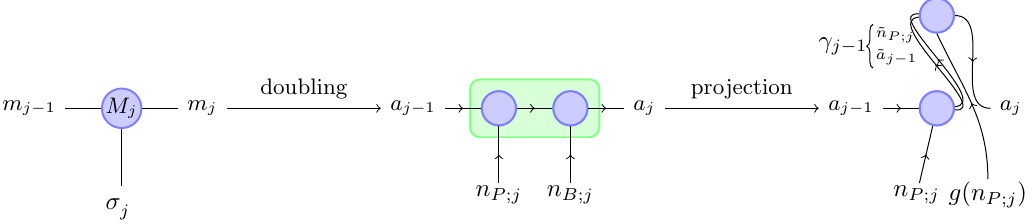
Figure 5: Decomposition of general MPS tensor (left) into U ( 1 ) -invariant physical and bath-site tensors (center). Projection of the U ( 1 ) -invariant MPS (center) into the subspace (right) enforcing the local gauge condition given in Eq. (17). De- P composition of the introduced auxiliary index ˜ a of the local conservation law generated by ˆ n γ → ( ˜ n ) , ˜ a j − 1 P ; j j − 1